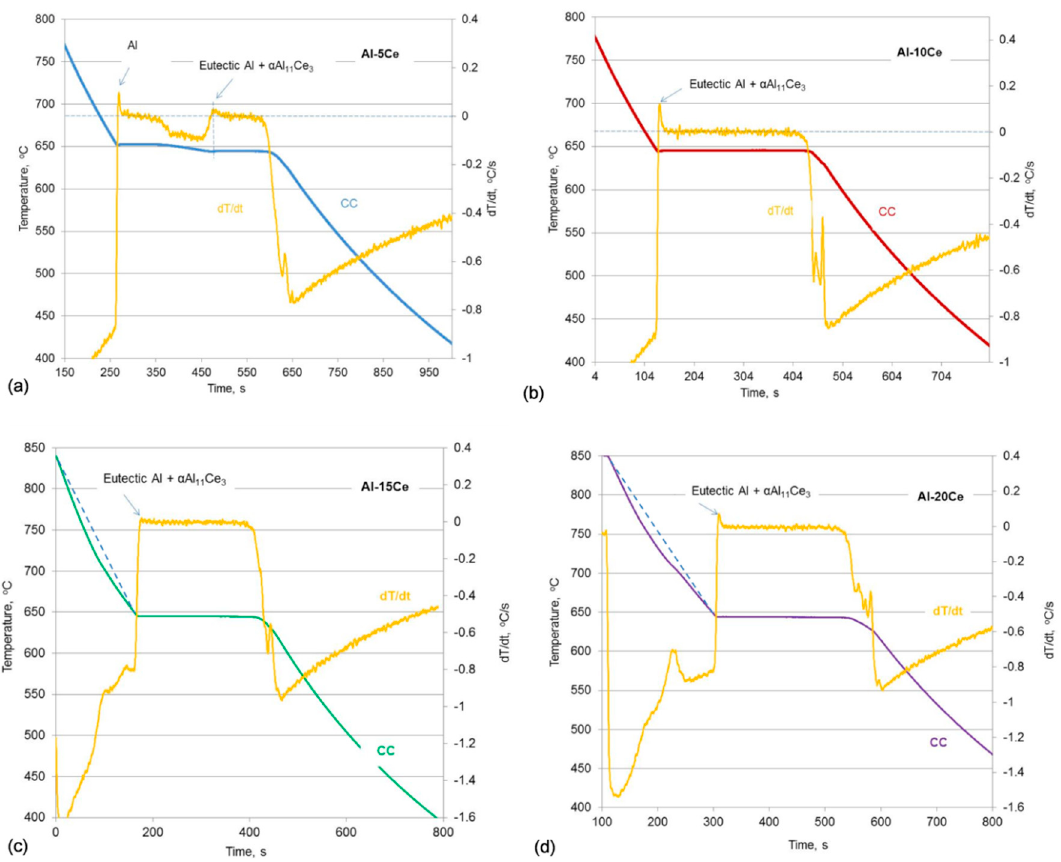
Figure 2. Computer-aided cooling curves’ thermal analysis showing the cooling curves (CCs) and the first derivative curves (dT / dt) plotted versus time with major thermal events recorded for Al–Ce alloys: ( a ) Al–5Ce; ( b ) Al–10Ce; ( c ) Al–15Ce; ( d )